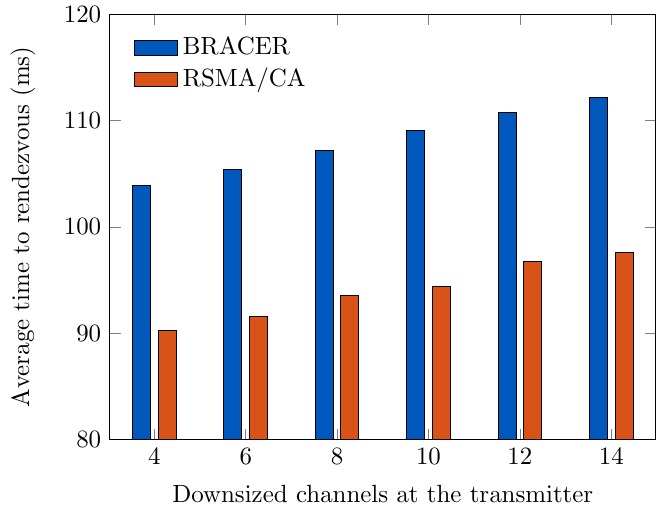
Figure 7. Average TTR vs. Y at the Tx (on Y = 15 at the